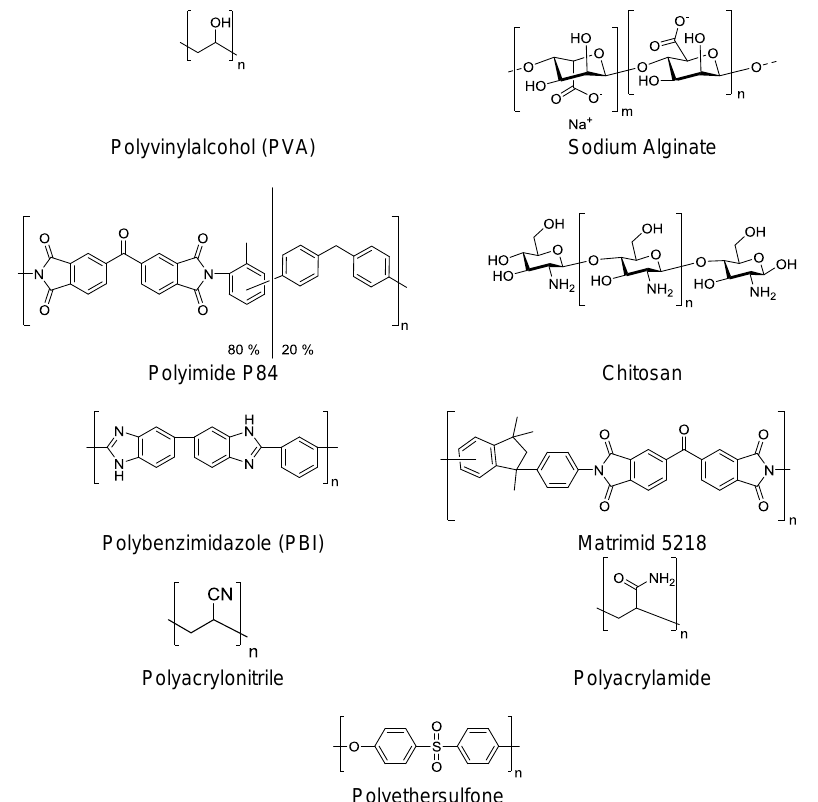
Figure 13. Examples of polymers for hydrophilic pervaporation membranes.